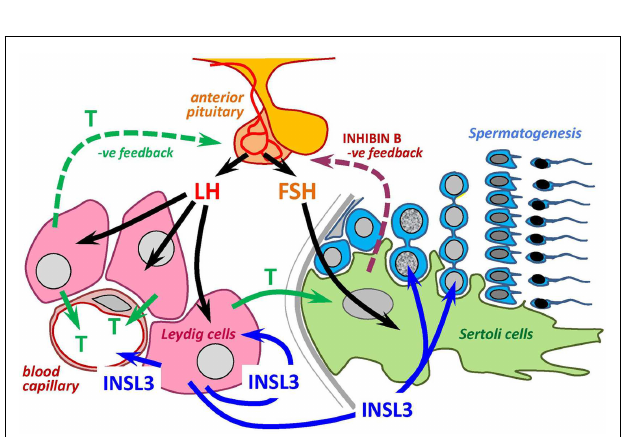
FIGURE 2 | INSL3 and HPG axis . Scheme to show the relationship between the INSL3/RXFP2 system and testosterone as endpoint effectors of the HPG axis within the testis. Arrows are directed only to cells where there are known to be specific cognate